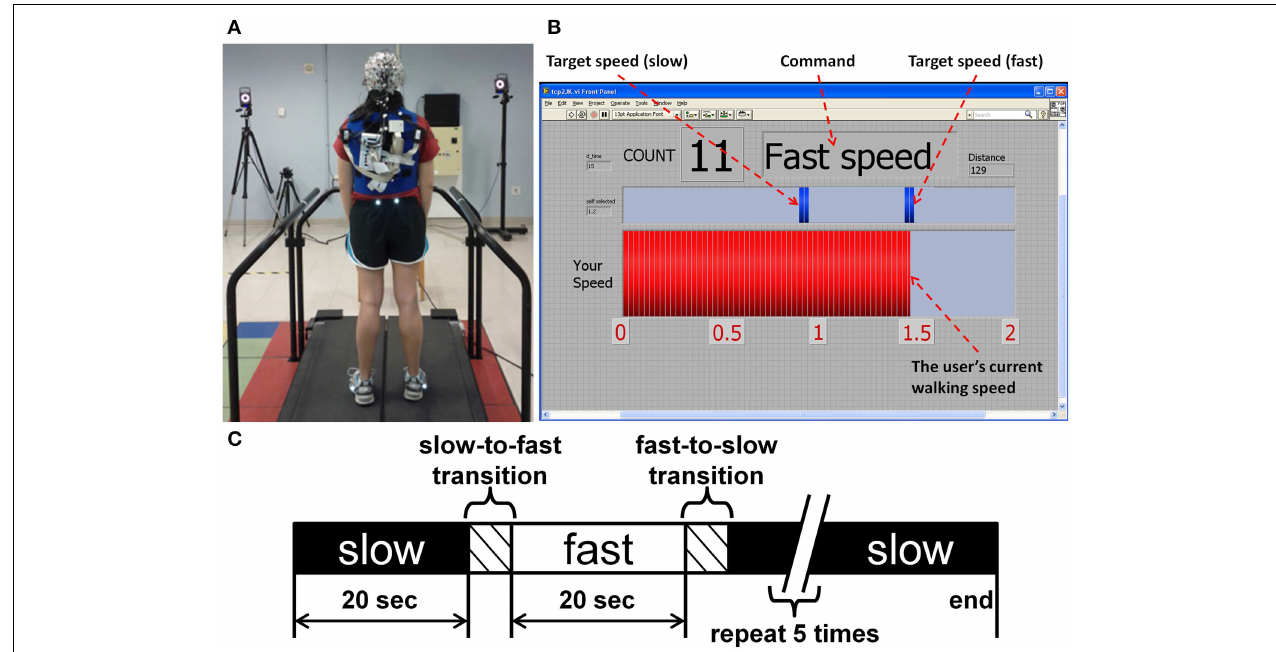
FIGURE 1 | (A) The experimental setup for EEG data collection during treadmill walking. (B) Computer screen providing real-time feedback of speed performance to the participant. (C) Block design of each trial.